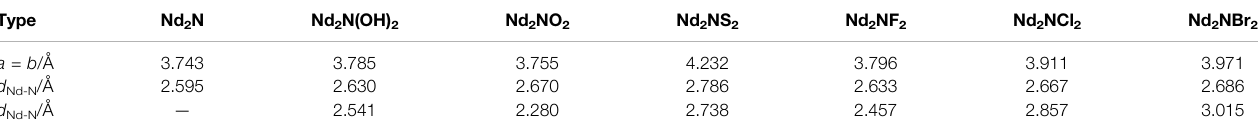
TABLE 1 | Lattice constants of the two-dimensional MXene materials Nd 2 N and Nd 2 NT 2 and bond lengths of Nd – N and Nd – T (T = OH, O, S, F, Cl, and Br). Type